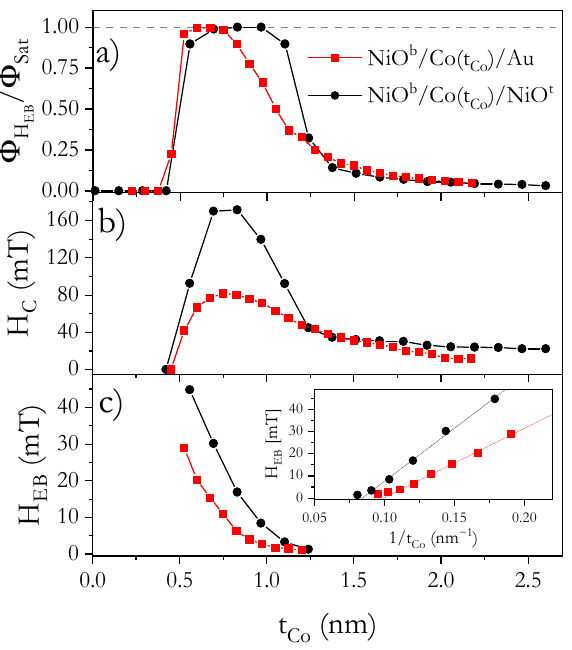
Figure 2. Dependence of normalized Kerr signal ( φ H exchange bias fields ( H EB ) ( c ) on Co layer thickness ( t Co ) for NiO b /Co/Au and NiO b /Co/NiO t systems. Inset in (c) shows H EB (1/ t Co ) dependence.